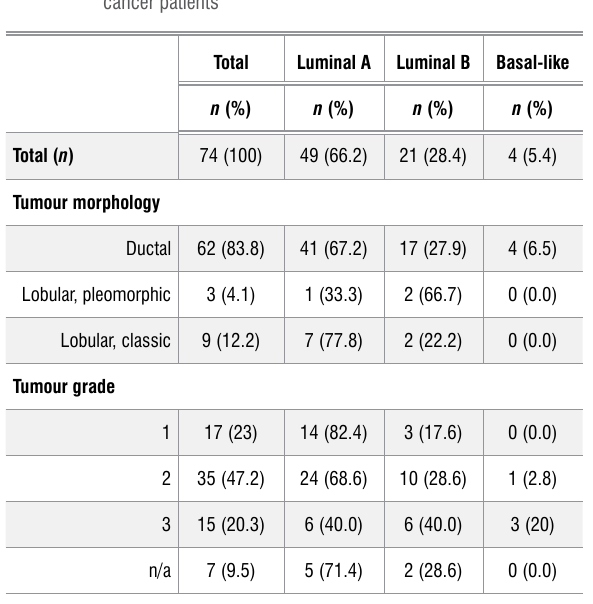
Comparison of tumour morphology and grade between breast cancer subtypes according to the BluePrint microarray